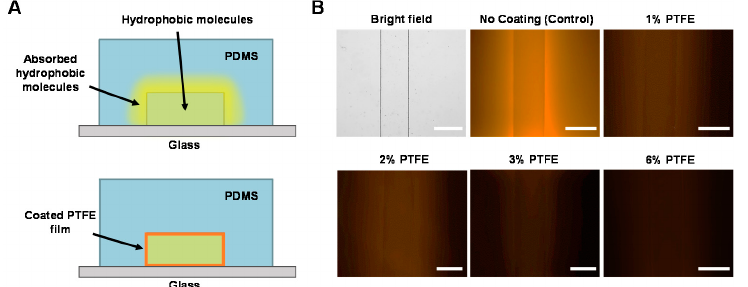
Figure 4. ( A ) Inhibition of hydrophobic molecule absorption on PDMS microchannel surfaces by PTFE coating. ( B ) Fluorescence images showing different levels of Nile red absorption of PDMS microchannels by different PTFE coating concentrations. Scale bars = 300 μ m.